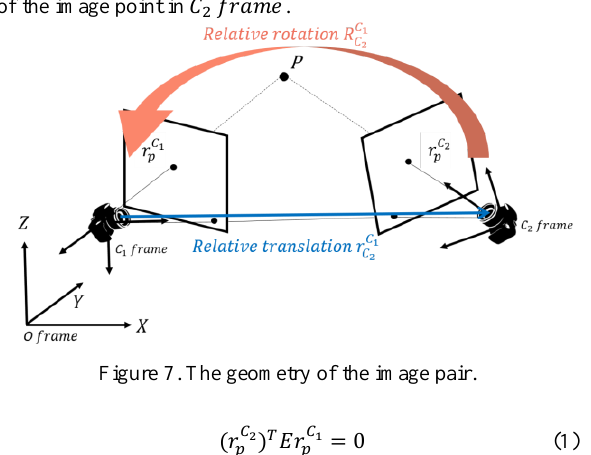
Figure 7. The geometry of the image